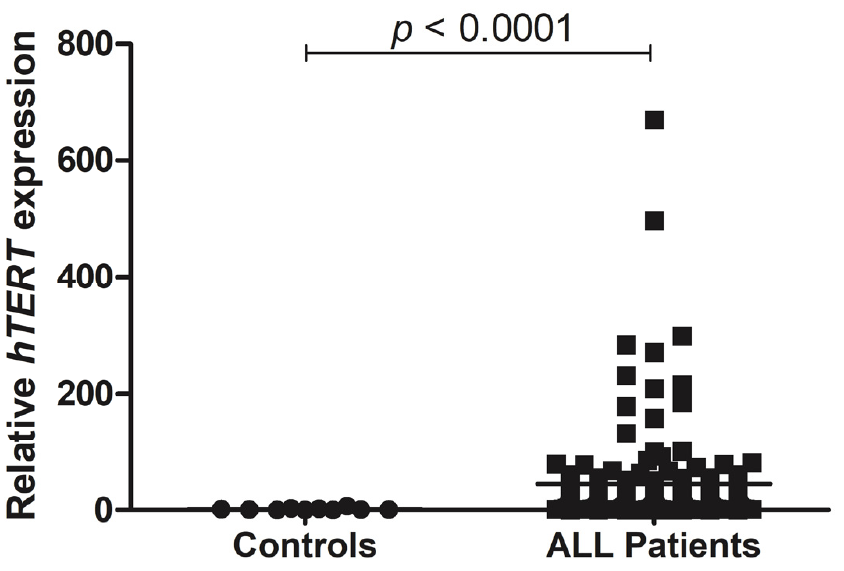
Figure 1. The ALL patients demonstrate enhanced hTERT expression. Gene expression analysis of hTERT in ALL blood samples from pediatric patients ( n = 244). Relative hTERT expression was calculated using ABL and GAPDH as endogenous normalizers. Data are presented as the median and each dot plot represents the hTERT expression in a single patient. For statistical analysis, the normal distribution was confirmed by the Shapiro–Wilk normality test followed by the Mann–Whitney test. Comparison with control samples: p < 0.0001. ALL: acute lymphoblastic